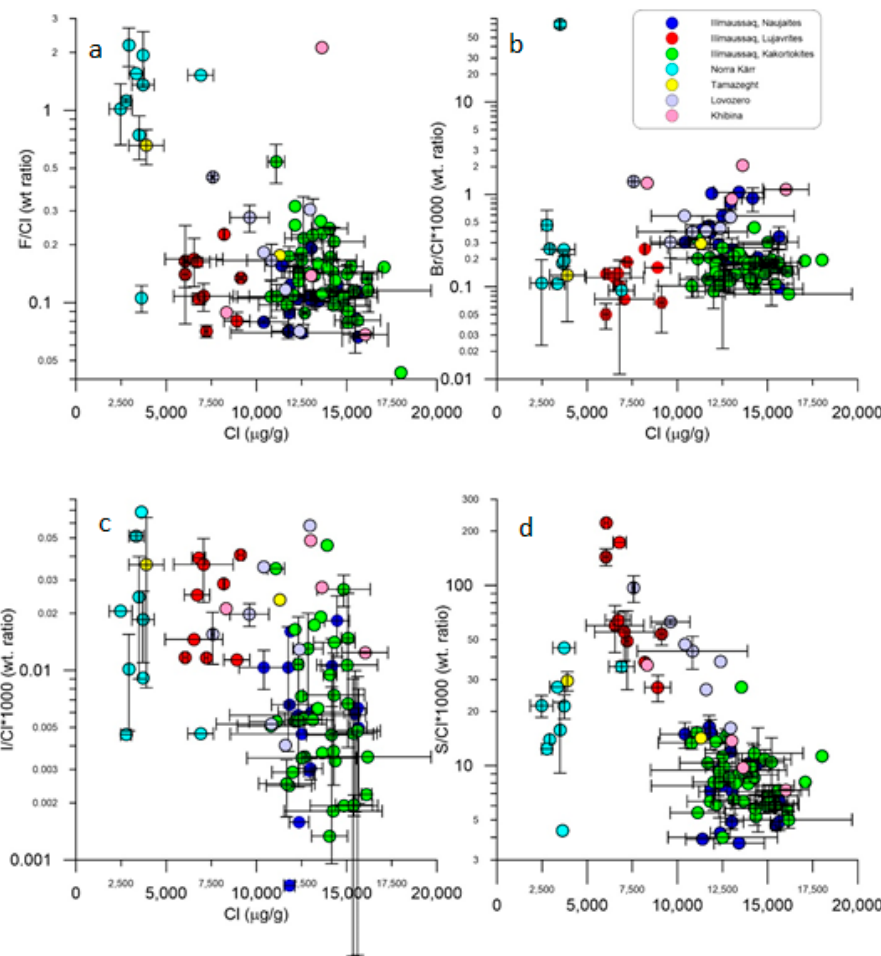
Figure 5. X / Cl versus Cl systematics in EGM. ( a ) Relationship between F / Cl and Cl. ( b ) Relationship Figure 5. X/Cl versus Cl systematics in EGM. ( a ) Relationship between F/Cl and Cl. ( b ) Relationship between Br / Cl × 1000 and Cl. ( c ) Relationship between I / Cl × 1000 and Cl. ( d ) Relationship between between Br/Cl × 1000 and Cl. ( c ) Relationship between I/Cl × 1000 and Cl. ( d ) Relationship between S / Cl × 1000 and S/Cl × 1000 and Cl.